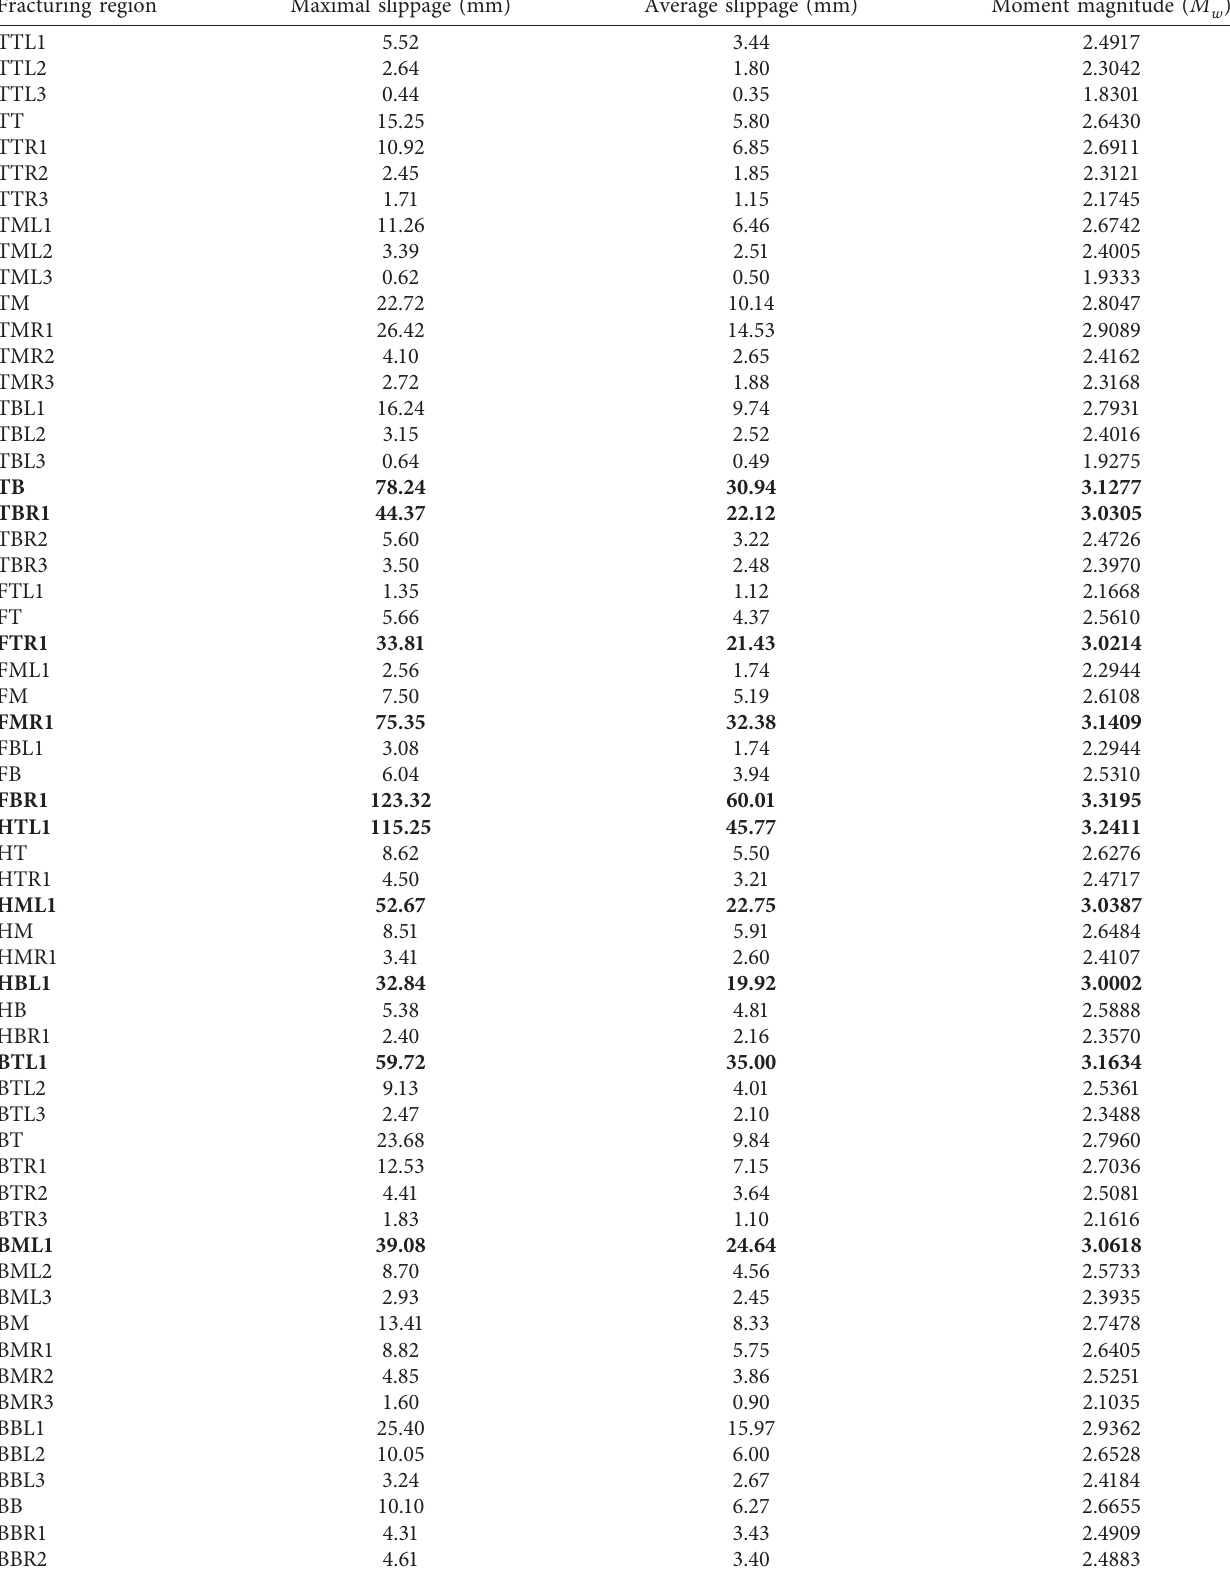
Table 2: The induced maximal slippage, average slippage, and moment magnitude of fault when the pressure was